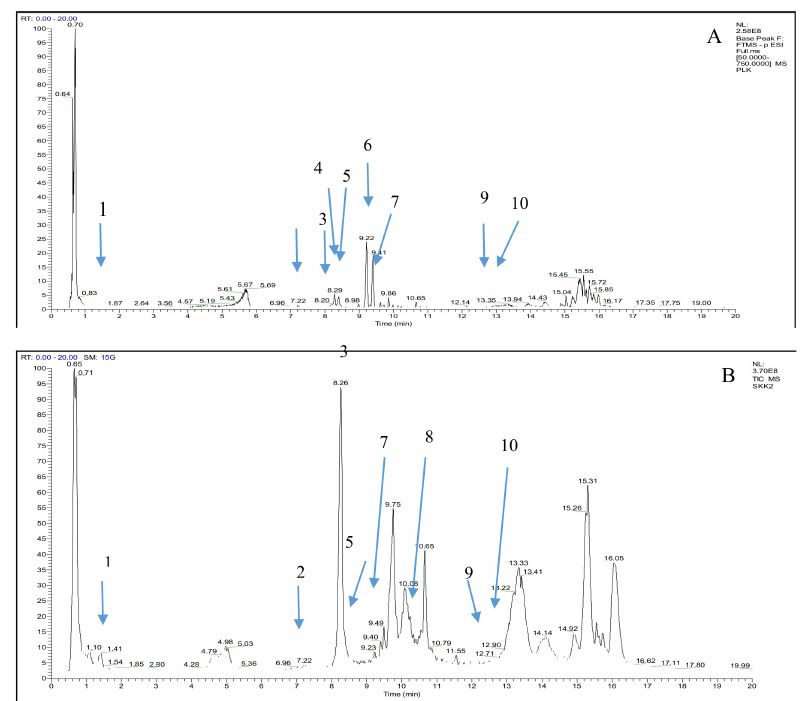
Figure 3. Total ion chromatogram from ethanol extracts of M. odorata ( A ) peel ( B ) seed kernel